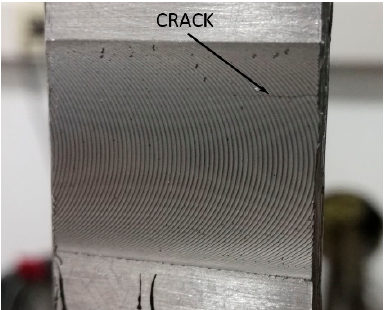
Figure 9. Crack propagation during FSWB-FI sample test.